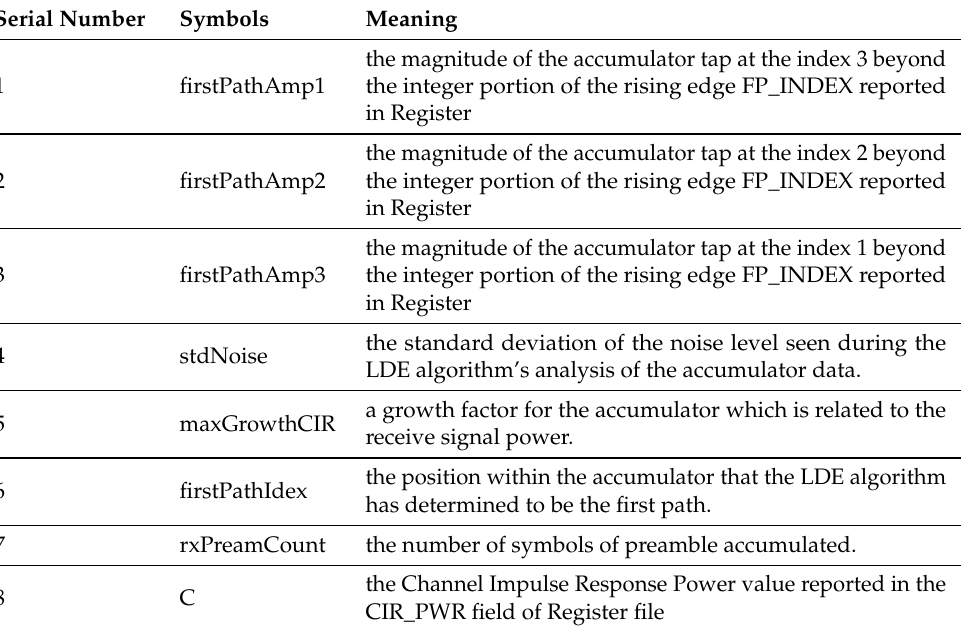
Table 1. Symbols of the frame transmit data we used to read from the